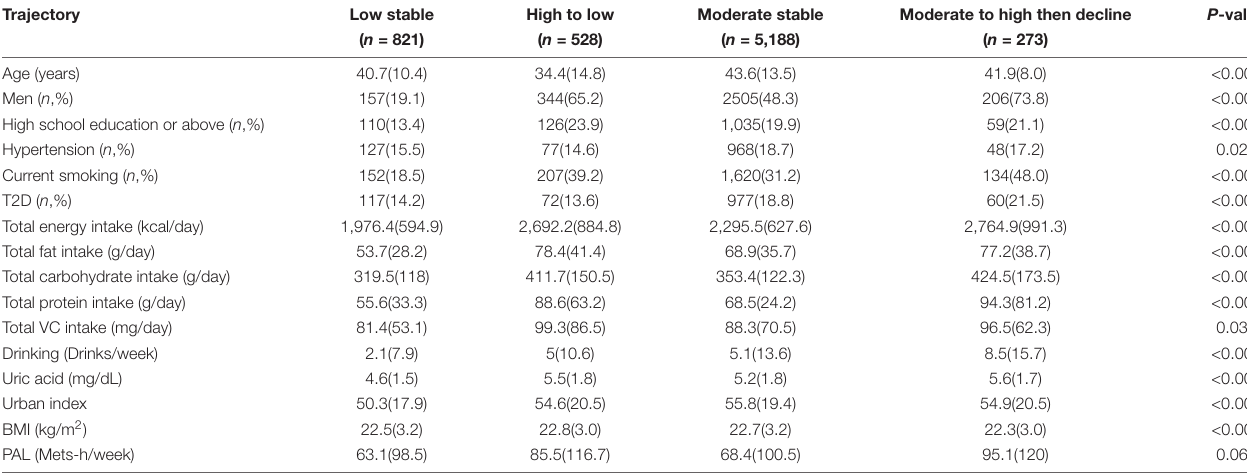
TABLE 1 | Baseline characteristics of study variables by different trajectories of dietary branched-chain amino acids (BCAA) consumption ( N = 6,810). Trajectory Low stable